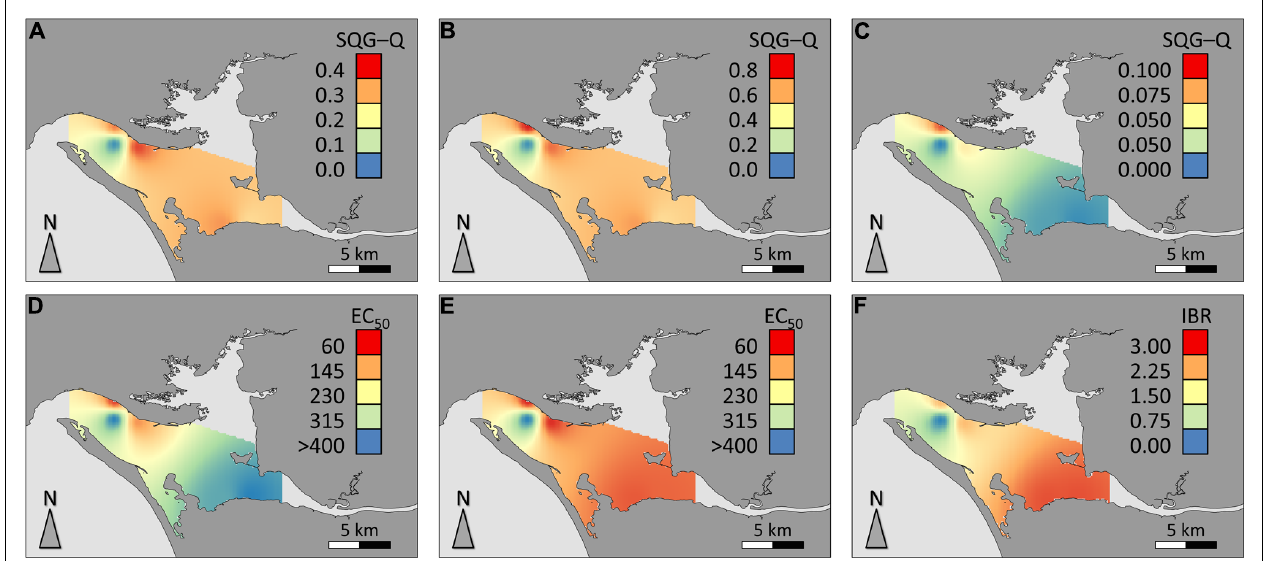
FIGURE 5 | Spatial distribution of data for the study area. (A) SQG-Q for total sediment contaminants (metals plus organic); (B) SQG-Q for sediment metals; (C) SQG-Q for organic sediment contaminants; (D) HepG2 EC 50 for DNA strand breakage (crude extract exposure); (E) HepG2 EC 50 for oxidative